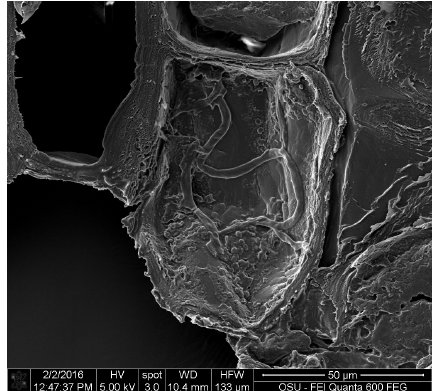
Figure 2. S. cuboideum hyphae developing inside a parenchyma cell on week 16.